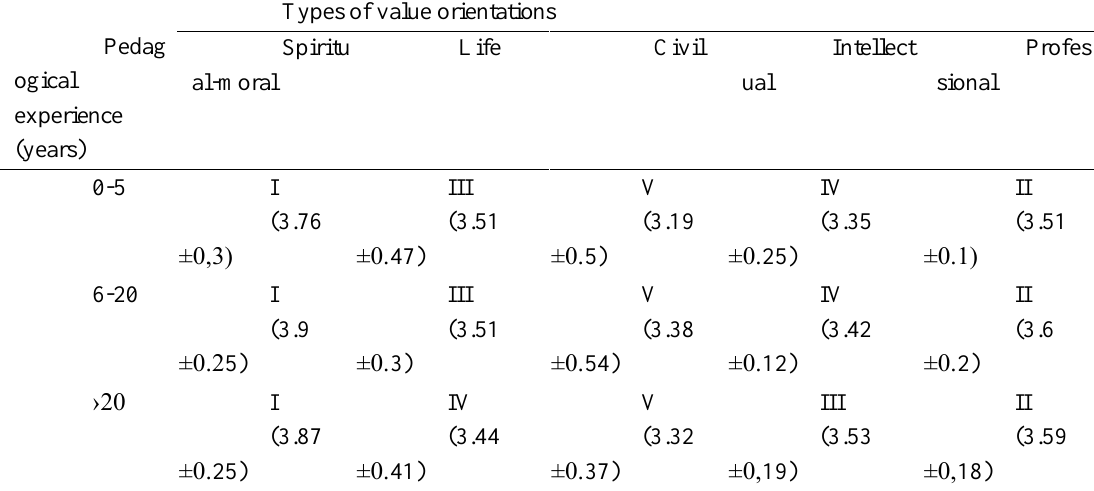
Table 5. Distribution of types of value orientations in Belarusian teachers with various teaching experience (ranks,